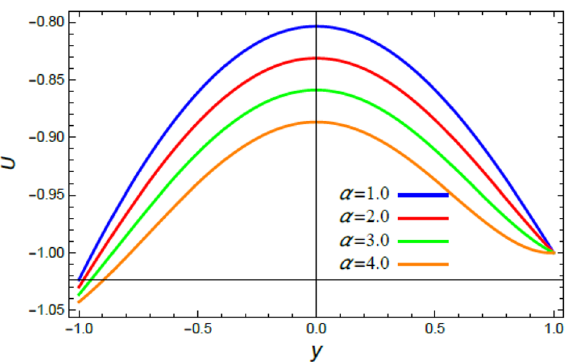
Figure 2. The effect of the pseudo plastic coefficient α on the speed distribution u